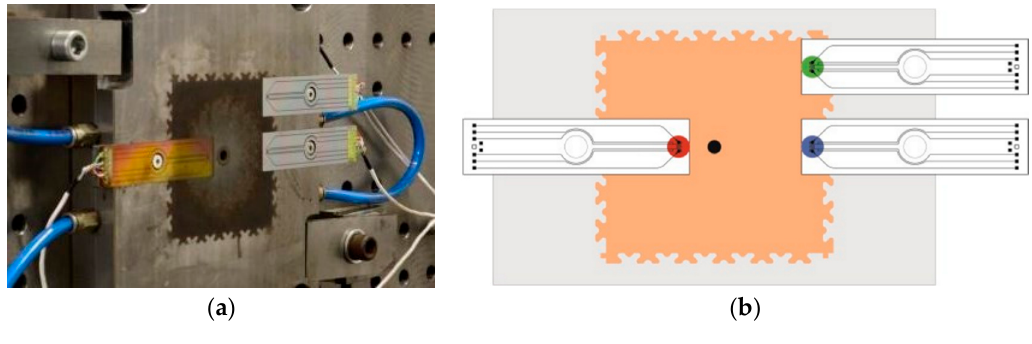
Figure 4. ( a ) Three integrated sensor modules in the polymer injection mold; ( b ) Color positioning of the three sensor